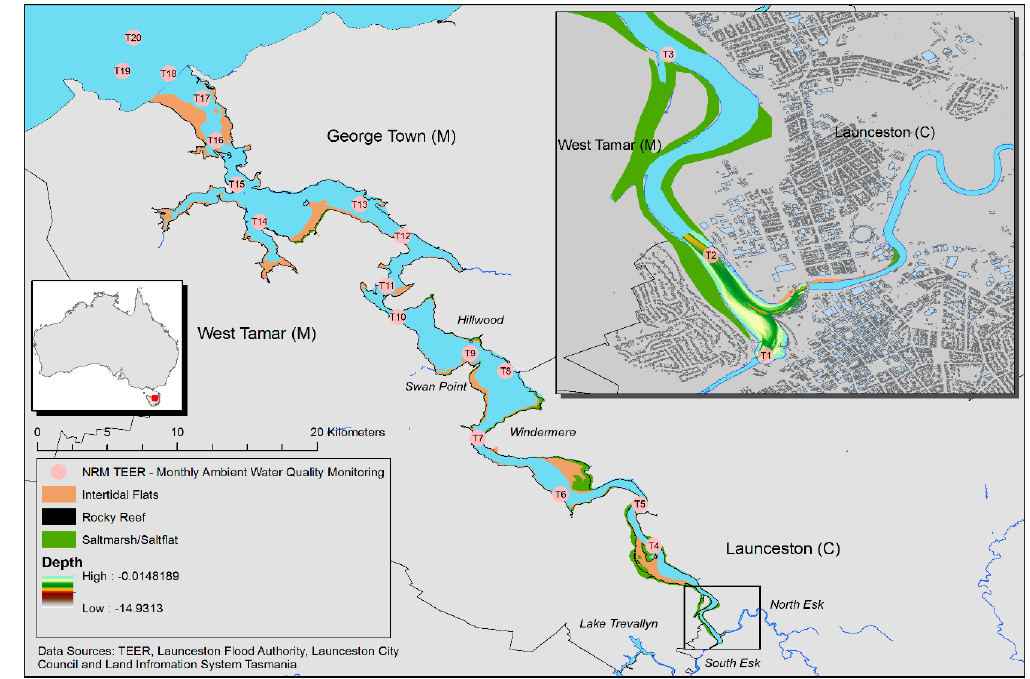
Figure 1. The study area with the distribution of monitoring sites (T1–T20) of the Tamar Estuary and Esk Rivers Ecosystem Health and Assessment Program (TEER EHAP). (Data: Geoscience Australia, NRM TEER EHAP Monitoring Program).